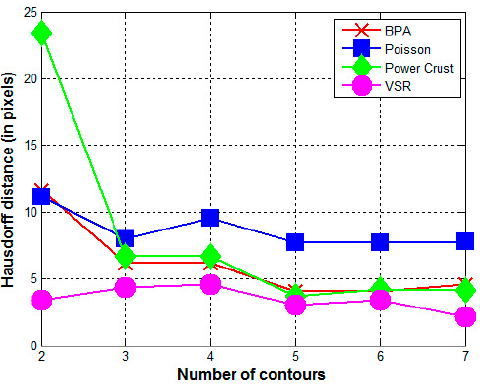
Figure 4. Surface reconstruction of an acorn by four methods. For each row, from left to right: the contours used, the original surface, the surface reconstructed by BPA, the surface reconstructed by Power Crust, the surface reconstructed by Poisson, and the surface reconstructed by VSR.